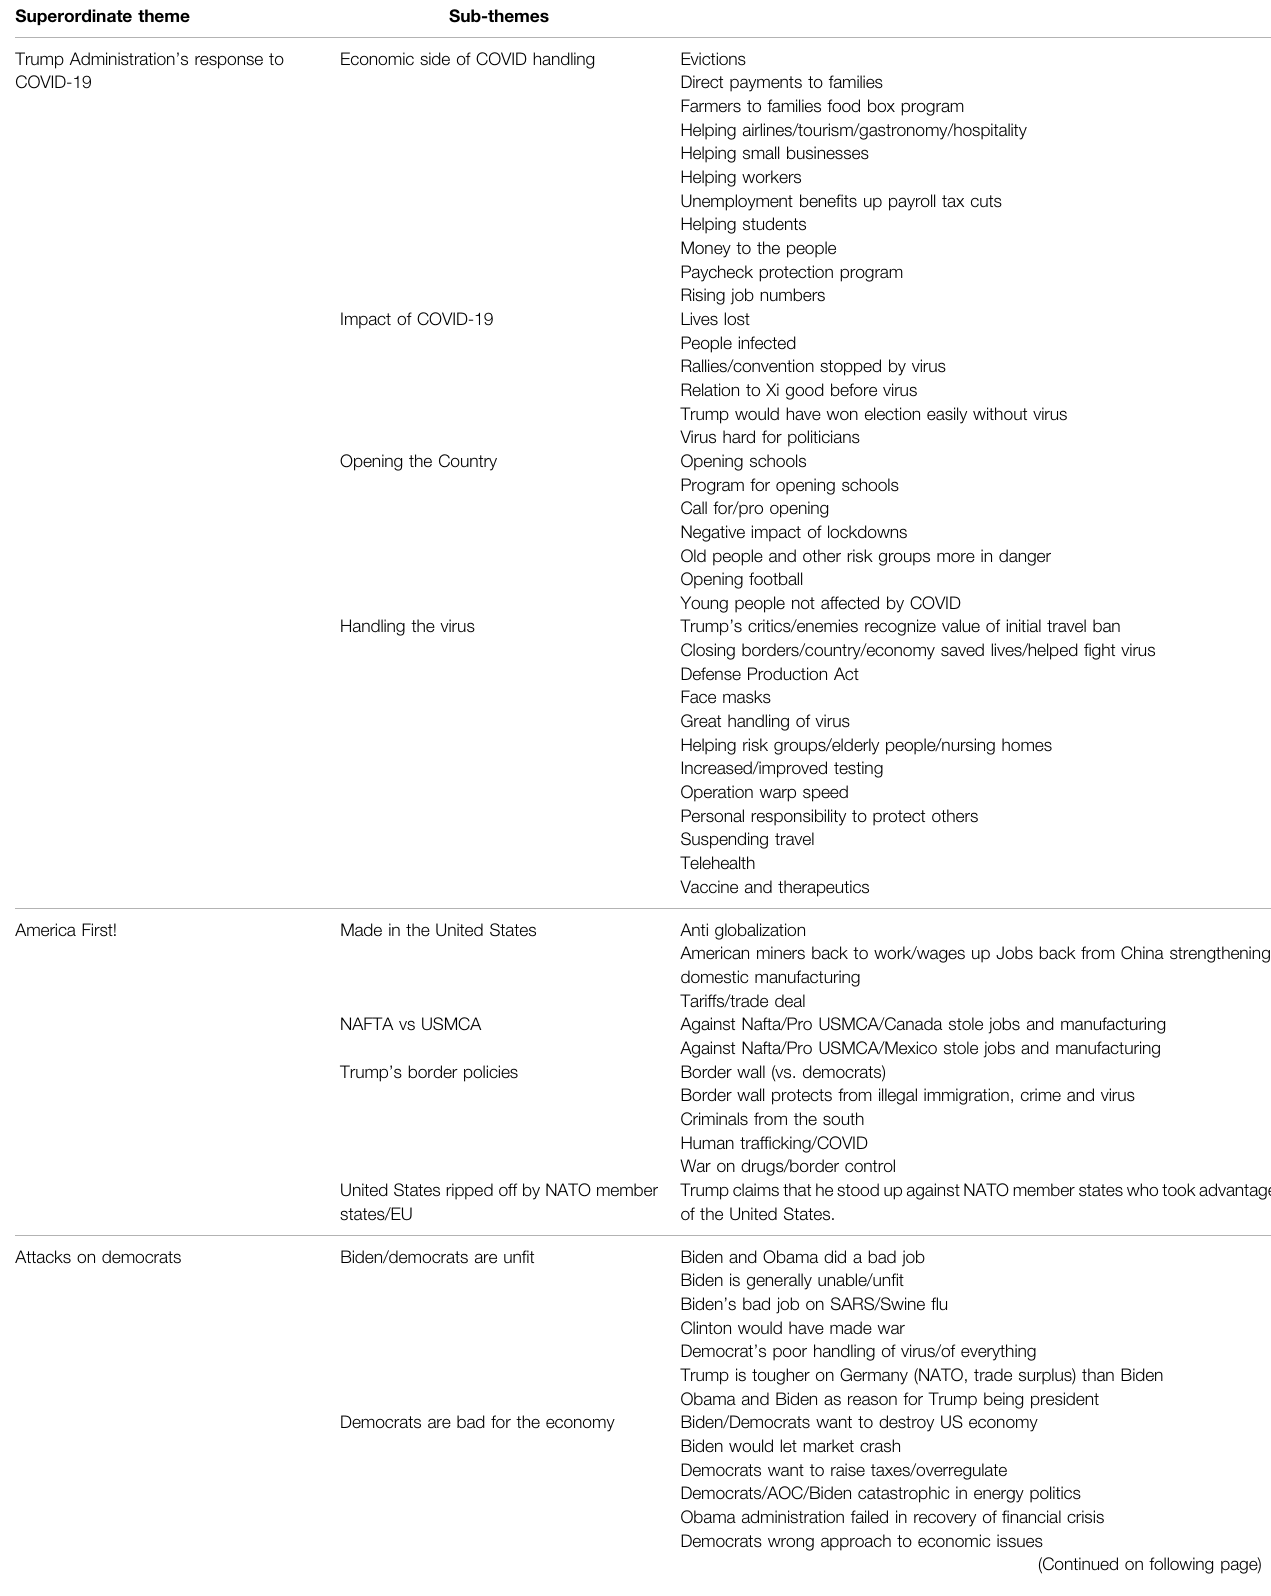
TABLE 2 | Themes, sub-themes, and